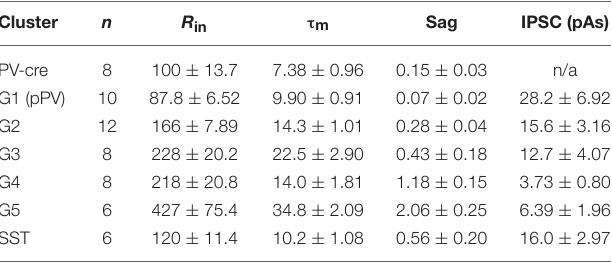
TABLE 2 | Intrinsic properties of interneurons that receive SST-mediated inhibition.